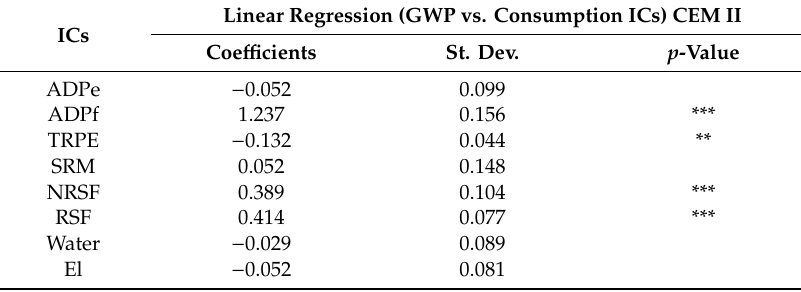
Table 10. Linear regression summary (GWP vs. Consumption ICs)—CEM II.